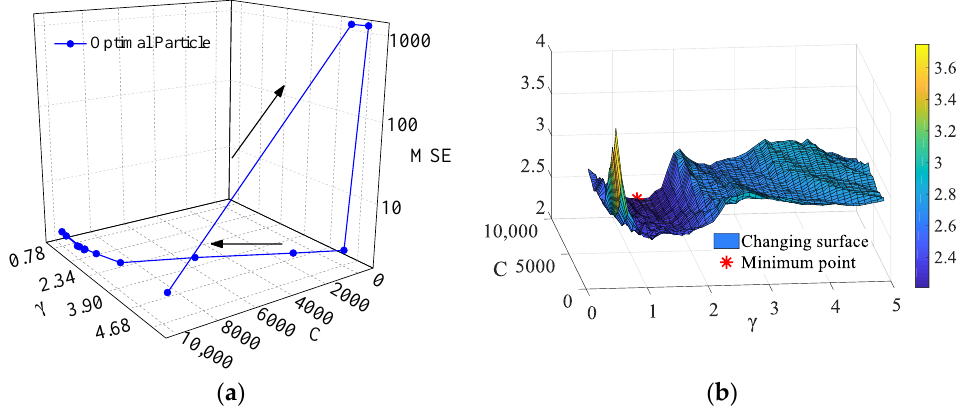
Figure 6. Iterative process of optimal particle. ( a ): Optimal particle change path; ( b ): Constraint error change surface. Table 2. Parameters of performance prediction model.